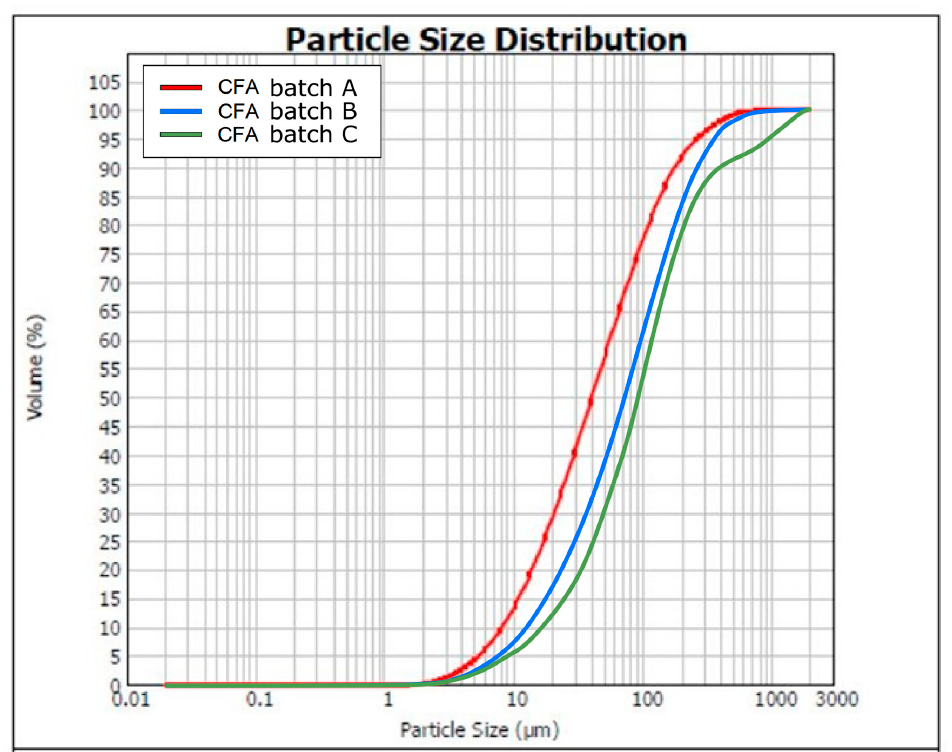
Figure 5. Cumulative distribution of ash grain size of CFA batch A, B, C.